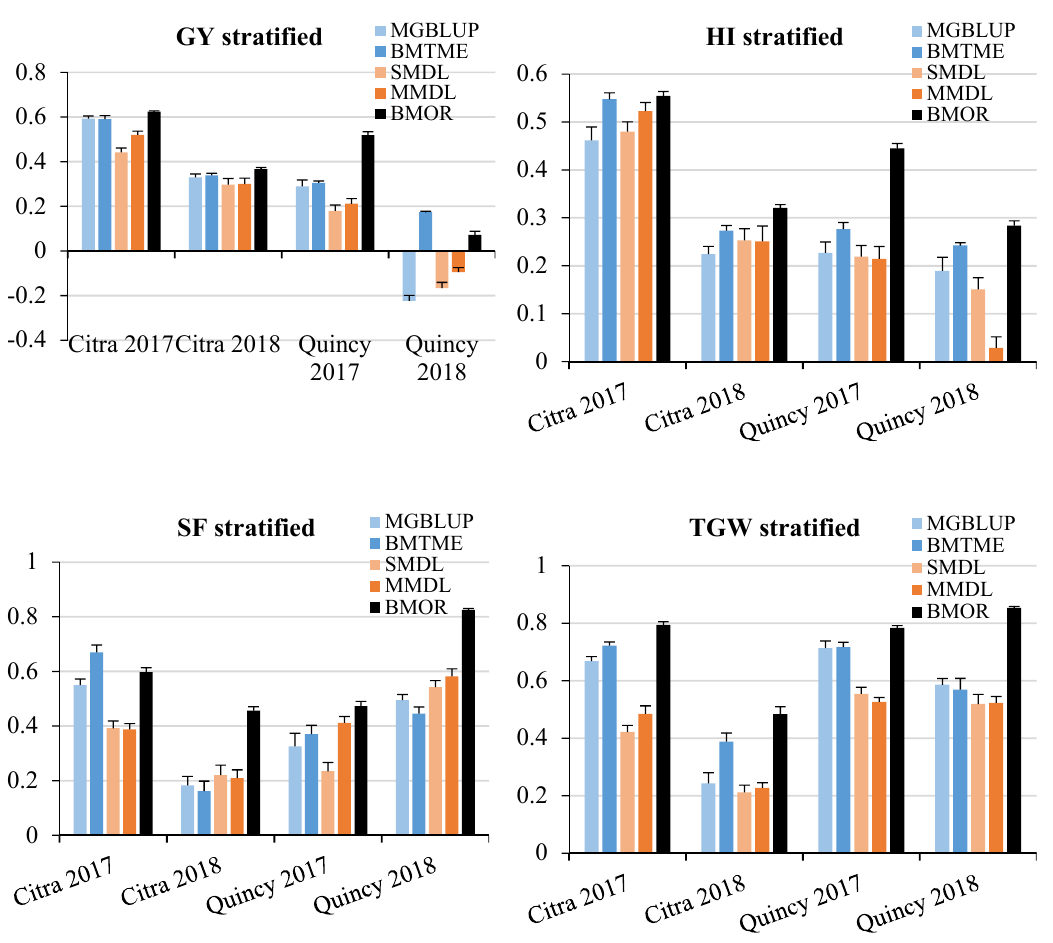
Figure 3. Prediction accuracies for GY, HI, SF, and TGW with population stratified. GY, grain yield; HI, harvest index; SF, spike fertility; TGW, thousand grain weight. Mean Pearson’s correlations and standard errors for each environment were presented for each trait. Statistical models were colored in light blue and blue while DL models were colored in light orange and orange. The BMOR model is colored in black.